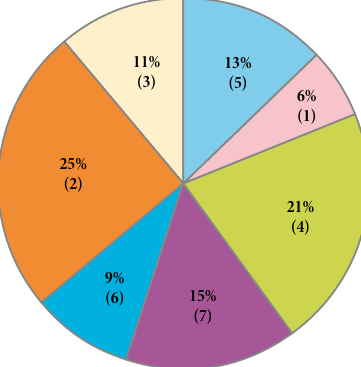
Fig. 12. Gathered data